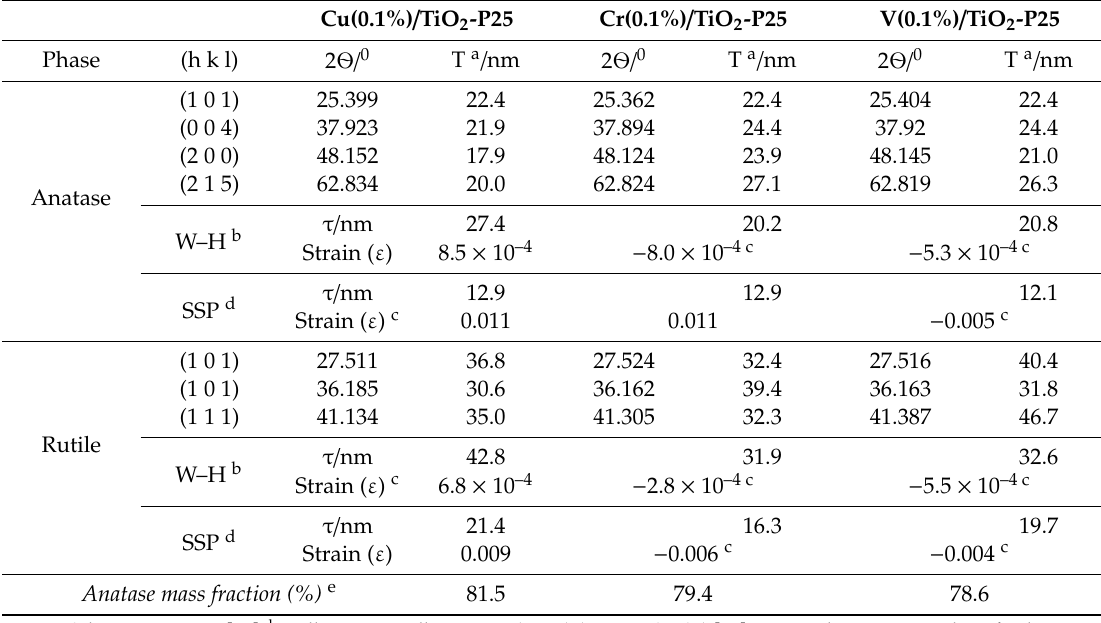
Table 1. Position of selected di ff raction peaks, crystallite size ( τ ), microstrain ( ε ), and anatase mass fraction of Cu, Cr, and V surface-impregnated TiO 2 -P25